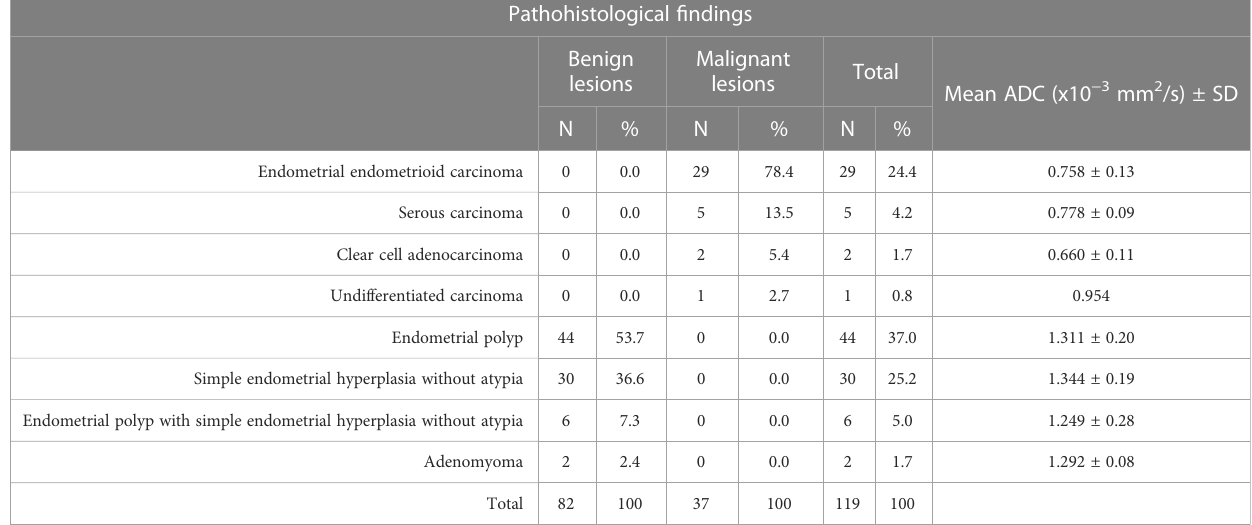
TABLE 2 Histopathological diagnoses of benign and malignant endometrial lesions.